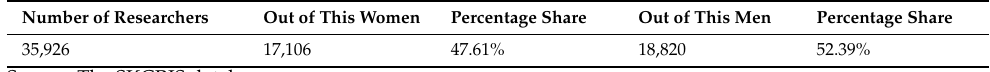
Table 3. Researchers in the researcher